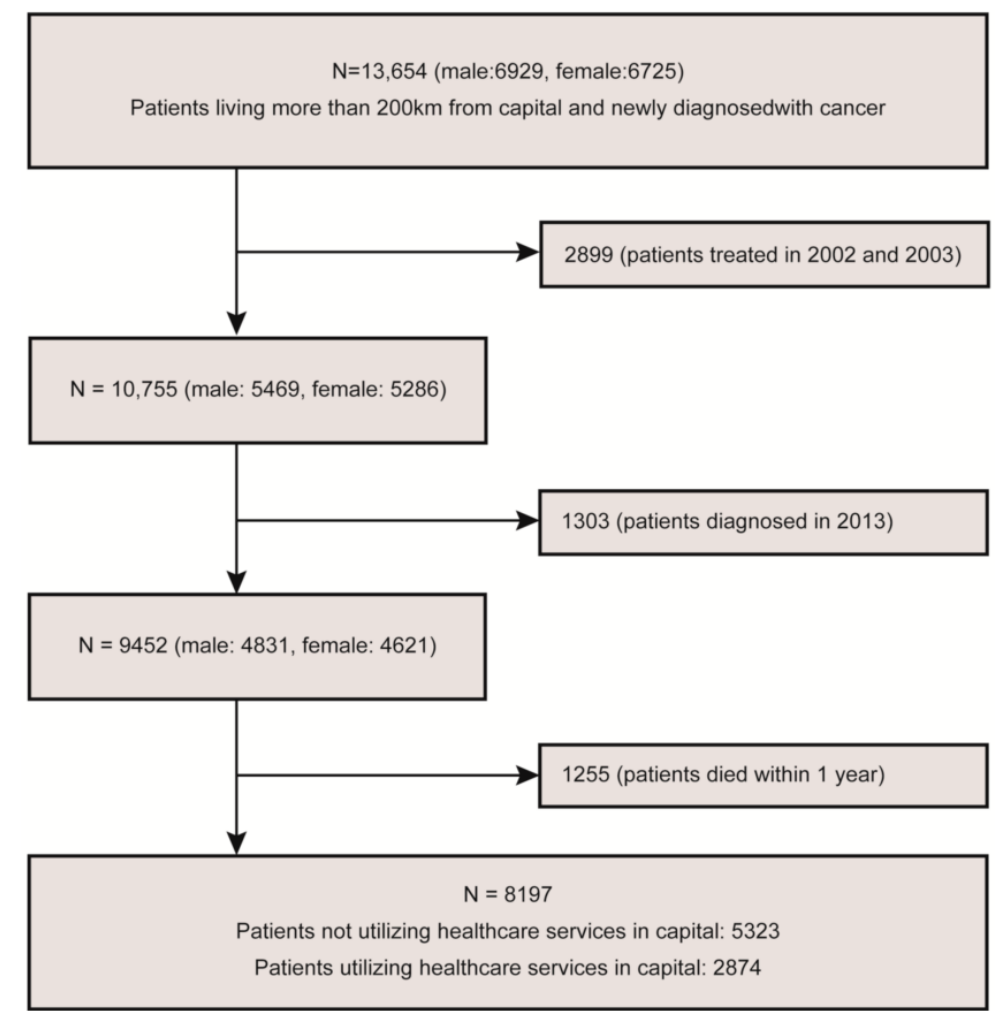
Figure 1. Flow chart of the patients included in the